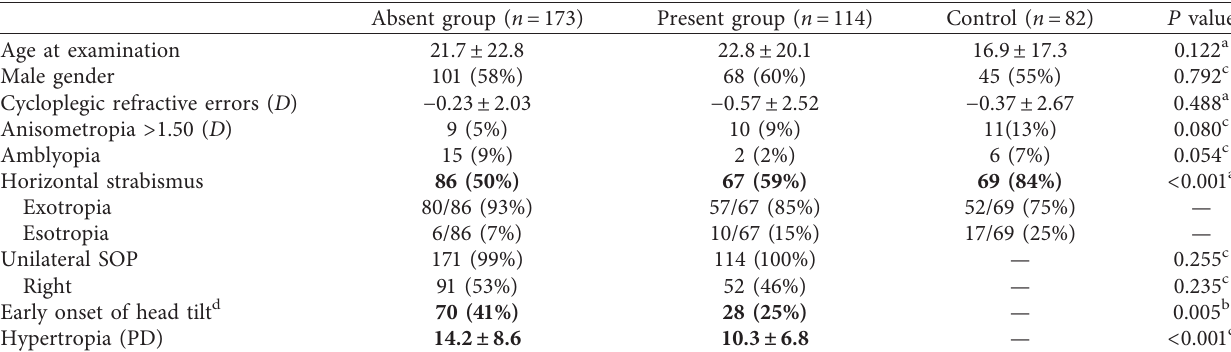
Table 1: Clinical characteristics of congenital superior oblique palsy patients with the absence of a trochlear nerve (absent group) and the presence of a trochlear nerve (present group) compared with controls.